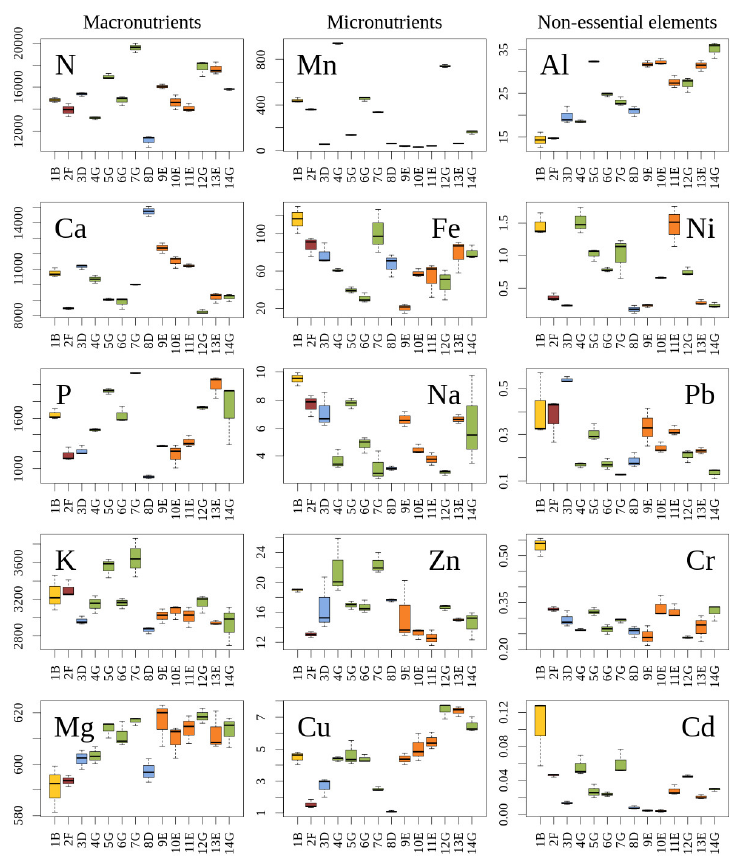
Figure 1. Concentrations ( µ g/g d. m. in y axes) of macroelements (N, Ca, P, K, Mg), microelements (Mn, Fe, Na, Zn, Cu) and non-essential elements (Al, Ni, Pb, Cr, Cd) in current-year needles of Lithuanian populations of J. communis ; x axes—titles of populations (title of each population consists of 2 characters: a number denotes geographical location (see map in Materials and Methods section), a letter denotes the type of habitat, boxes of different color denote distinct habitats). The central line of each box indicates a median value; the boxes, the lower (25%) and upper (75%) quartiles, and the whiskers are from 10 to 90 percentiles (typical